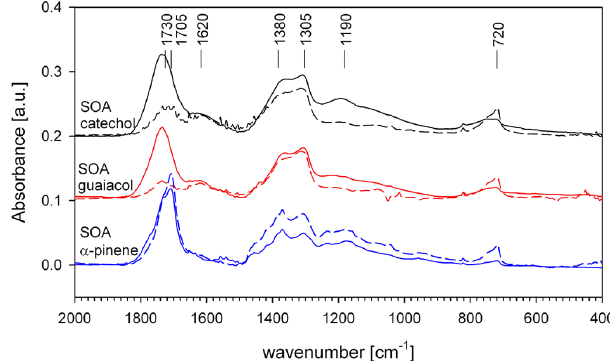
Fig. 11. ATR-FTIR spectra of the unprocessed SOA models (solid line) and processed with RHS (dashed line) released from the sim- ulated salt pan,